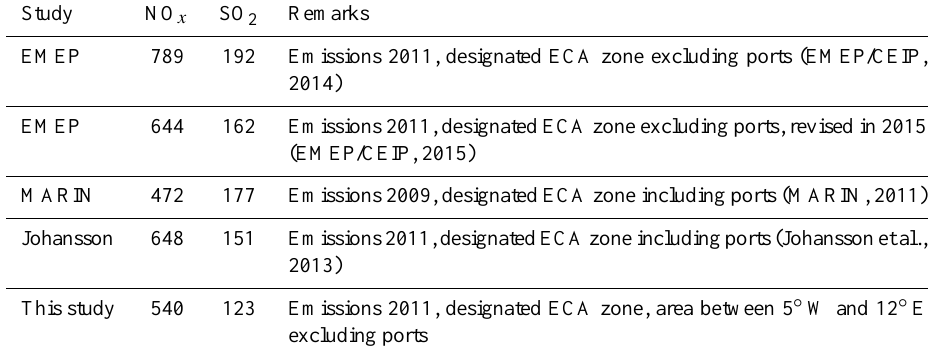
Table 4. Comparison of ship emissions in the North Sea in Gigagrams estimated in different studies. Study NO x SO 2 Remarks